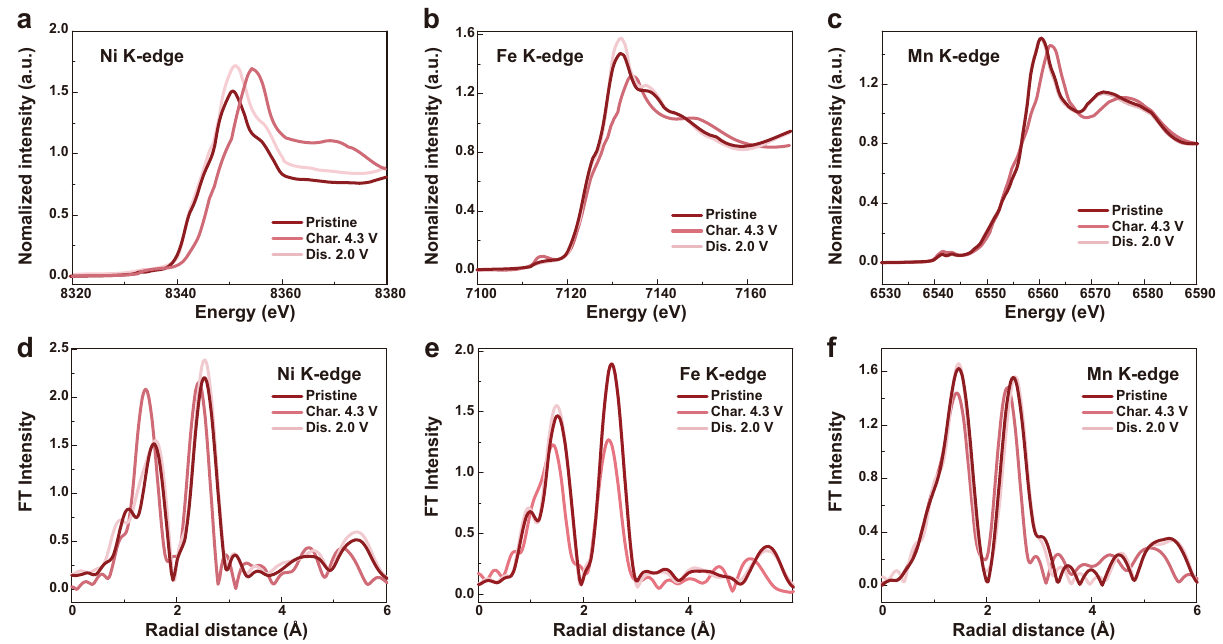
Fig. 7 Charge compensation mechanism upon at the fi rst cycle in half-cell con fi guration. Ex situ XANES spectra at the Ni ( a ), Fe ( b ), Mn ( c ) K-edge of NLNFMB at different charge/discharge states. Corresponding ex situ EXAFS spectra at the Ni ( d ), Fe ( e ), Mn ( f ) K-edge of NLNFMB electrodes at different charge/discharge